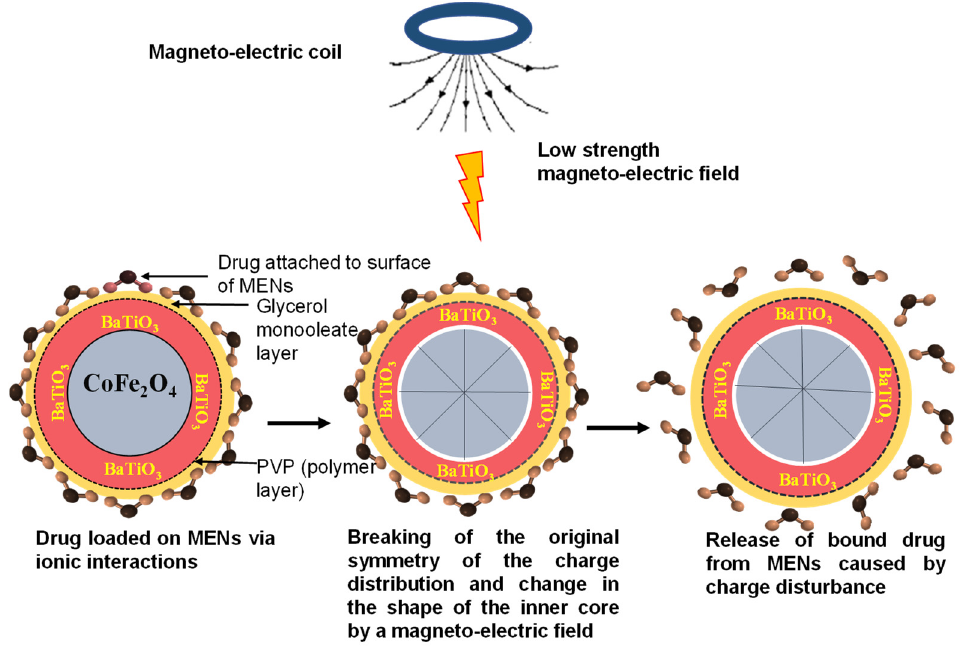
Figure 3. Schematic diagram of the effect of an applied magneto-electric field on core-shell MENs. MENs surrounded by a polyvinylpyrolidone (PVP) polymer layer and glycerol monooleate layer with a drug loaded on the surface of MENs. Upon the introduction of low strength magneto-electric field, the original symmetry of the charge distribution breaks and the shape of the inner core of MENs changes (i.e., magnetostriction) and changes the shape of the piezoelectric shell resulting in the release “shaking off” of the drug bound to MENs caused by charge disturbance.